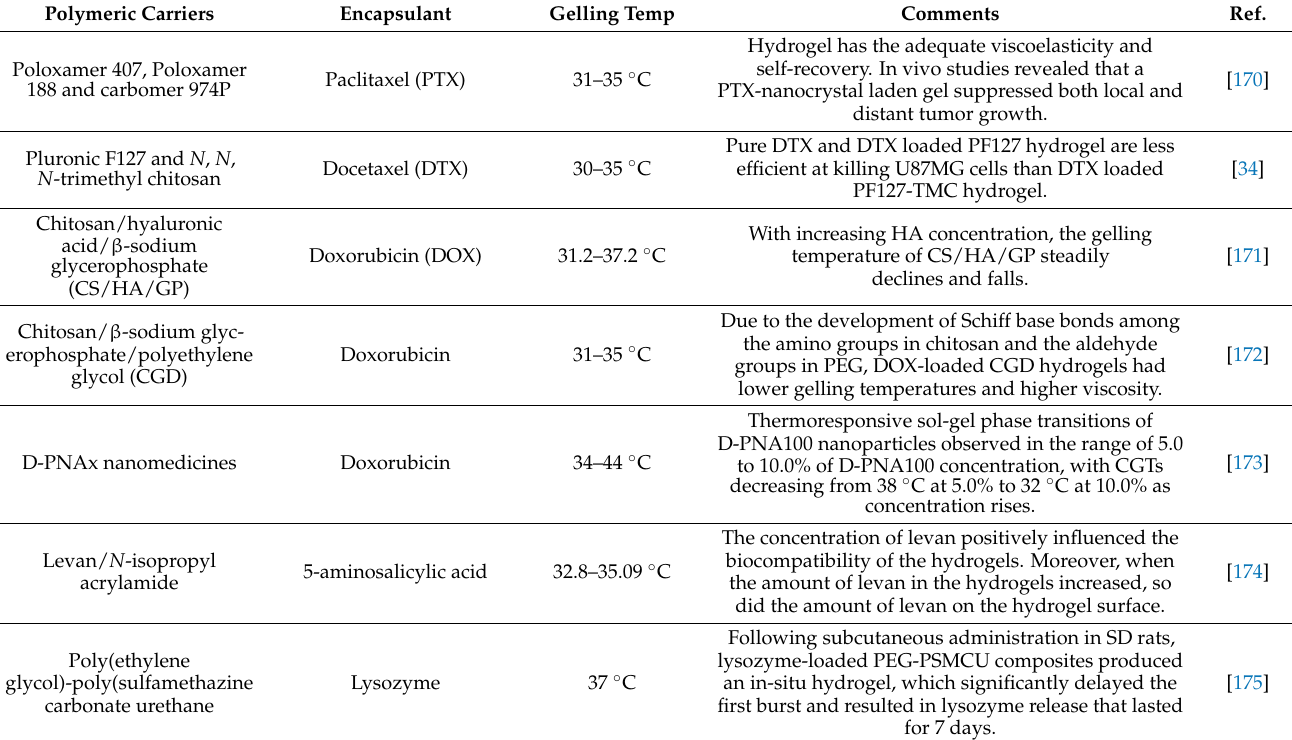
Table 4. Thermoresponsive hydrogel containing biotherapeutics for the treatment of various diseases. Polymeric